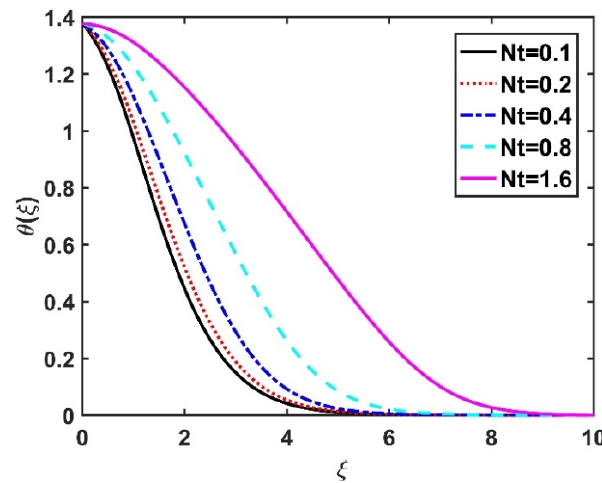
Figure 13. Impact of Nt on θ ( ξ )